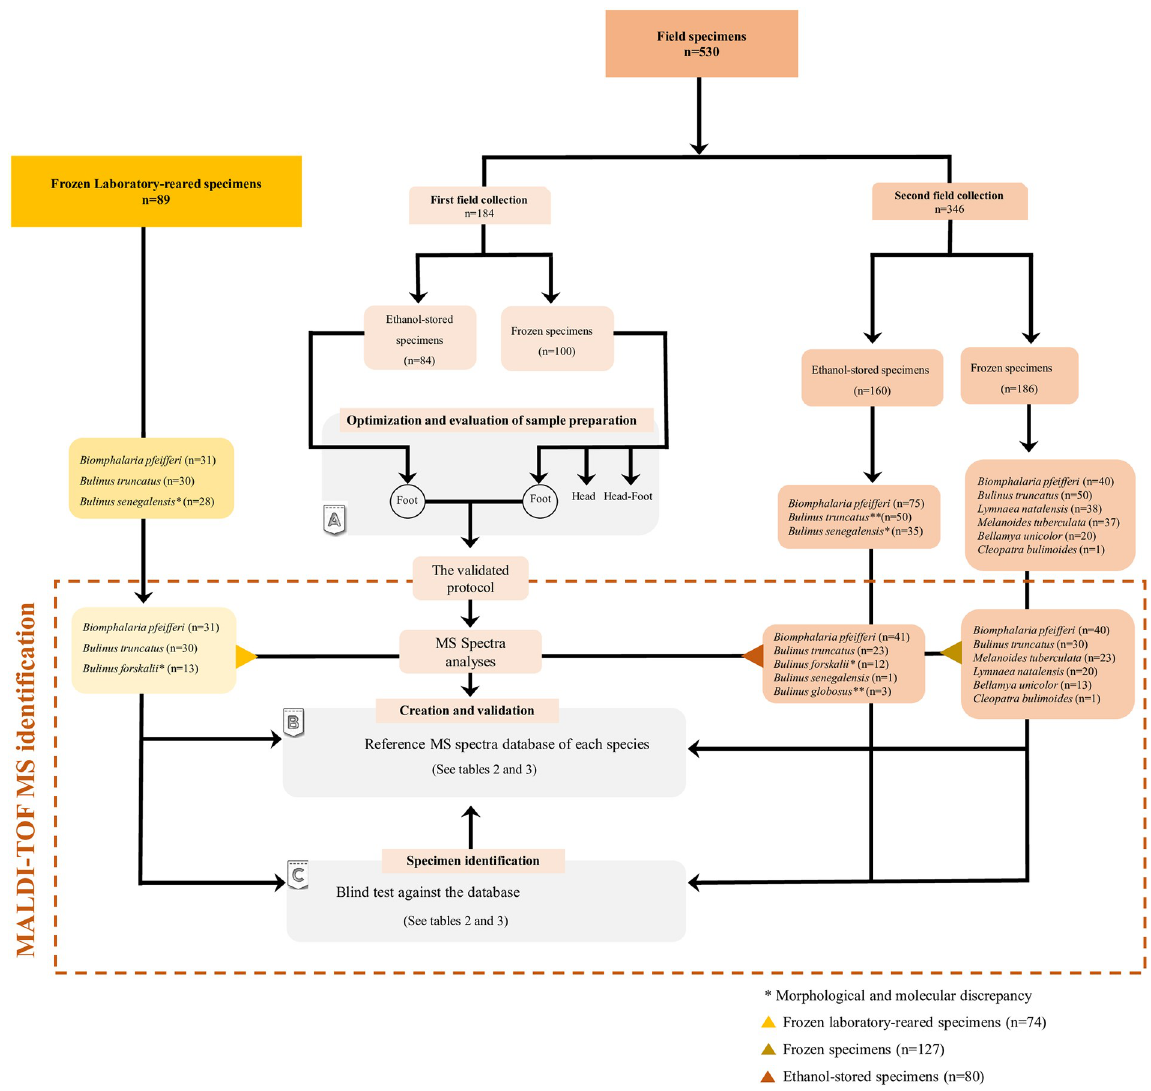
Fig 2. Flowchart showing the study design and all samples collected from the first and second field collection [2018–2019] and those used for each step in the study. The study design is divided into three sections: (A) protocol optimisation, (B) database creation and (C) the validation with a blind test. The number and the species of field and laboratory-reared freshwater snails are